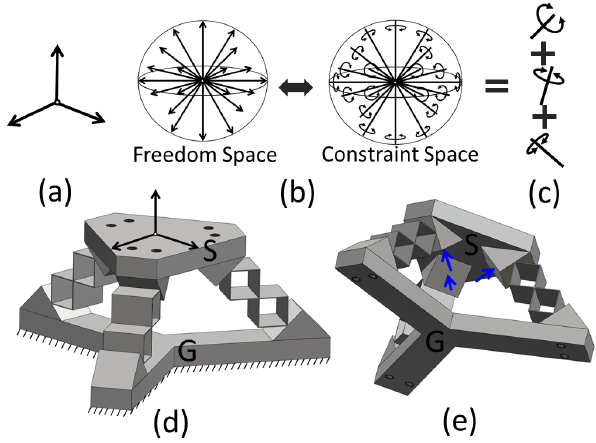
Figure 14. Desired DOFs (a) , the system’s freedom and constraint space (b) , three limb constraint spaces (c) , final hybrid system (d) , and locations for actuating the system (e)